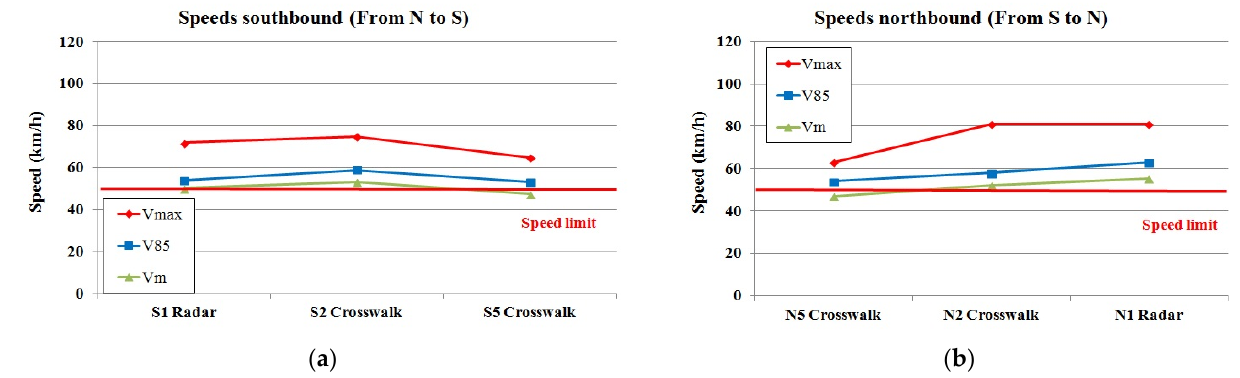
Figure 7. Speed at each controlled point in Suchowola (Poland): ( a ) southbound, ( b ) northbound.